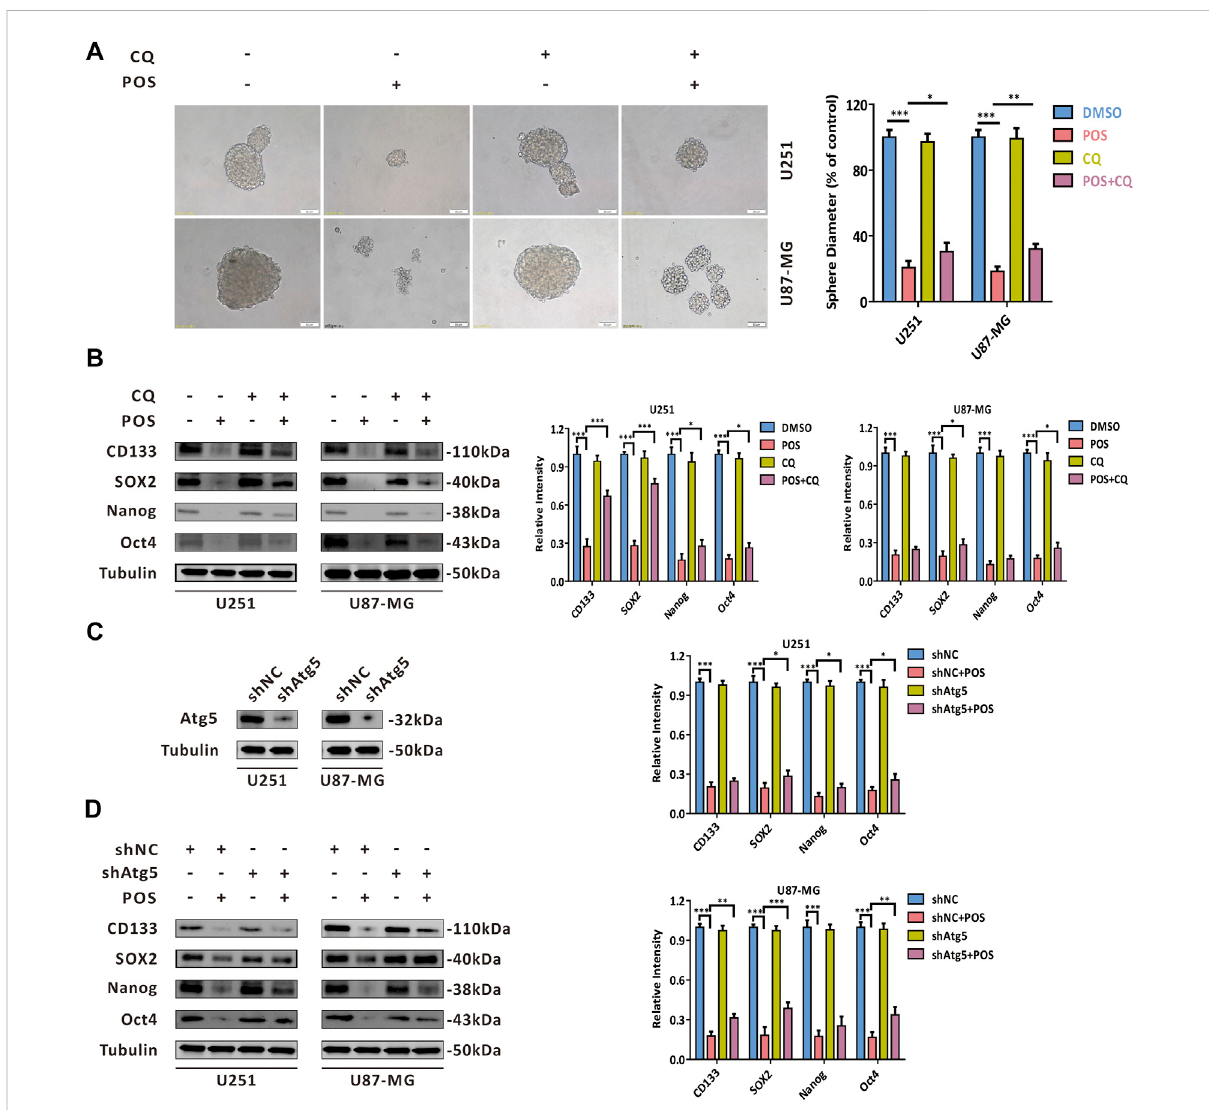
FIGURE 4 POS impairs CSCs stemness via inducing autophagy in GBM cells. (A) Self-renewal capacity was detected by a sphere formation assay after the cells were treated with or without POS in the presence or absence of CQ for 2 weeks. Scale bar, 50 μ M. (B) Expression levels of the CSCs marker proteins CD133, SOX2, Nanog and Oct4 were measured by western blotting after the cells were treated with or without POS in the presence or absence of CQfor 24 h. (C) Ef fi cacy of Atg5 shRNA wasvalidatedby western blotting. (D) Expression levels oftheCSCs marker proteins CD133, SOX2, Nanog and Oct4 were examined by western blotting after the Atg5 shRNA or shNC cells were treated with or without POS for 24